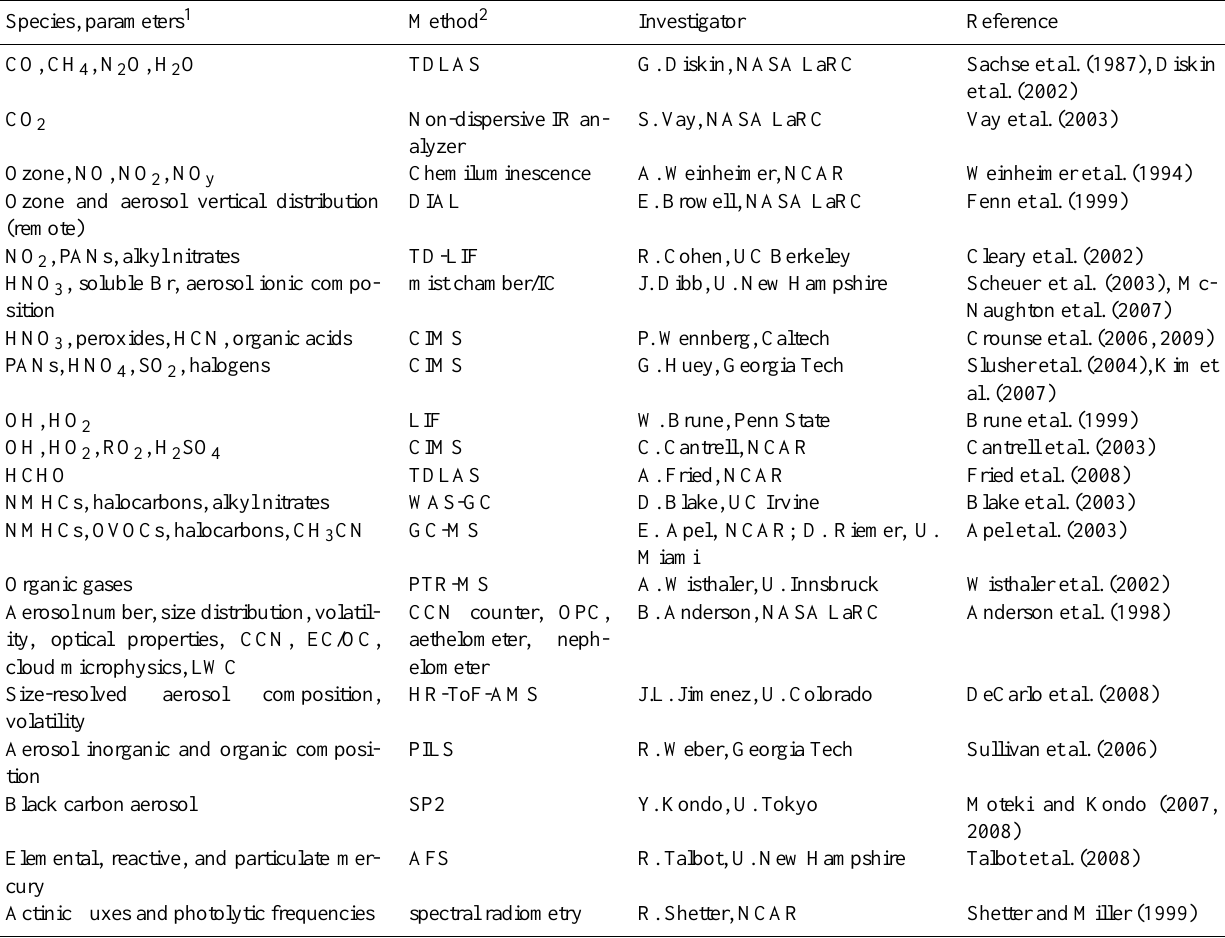
Table 3a. DC-8 research payload in